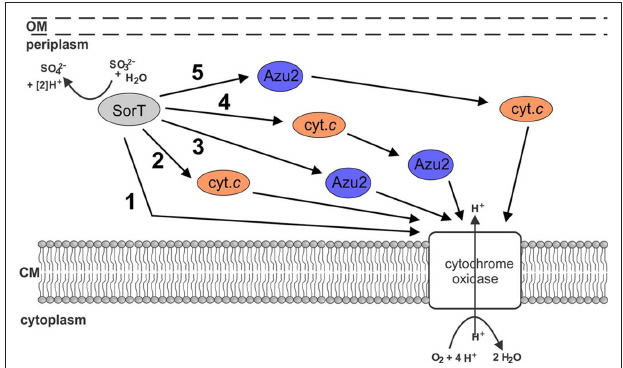
Figure 1 | Schematic representation of potential electron transfer pathways between SorT and the respiratory chain. 1 direct transfer of electron transfer between SorT and the cytochrome oxidase 2 using the Smc04048 cytochrome c as an electron carrier, 3 using the pseudoazurin Azu2 as an electron carrier, 4 + 5 using both the Smc04048 cytochrome c and pseudoazurin Azu2 the as